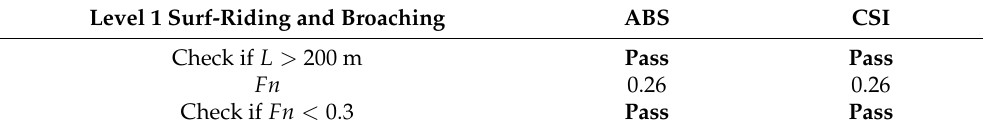
Table 34. Level 1 assessment of surf-riding and the broaching failure mode for the KCS container ship.